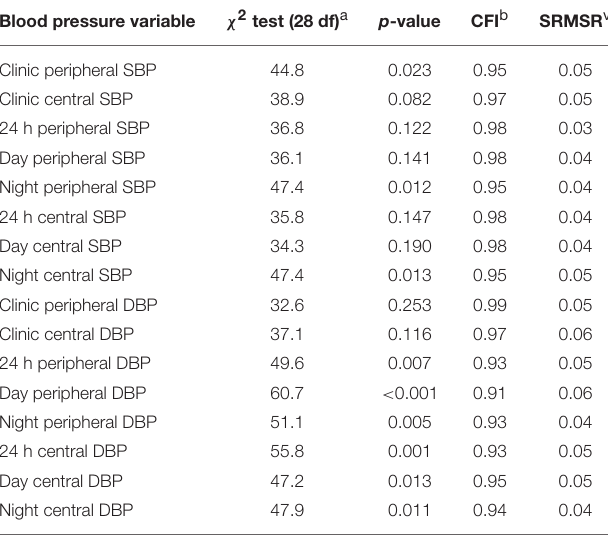
TABLE 3 | Indices of model fit for each of the 16 blood pressure